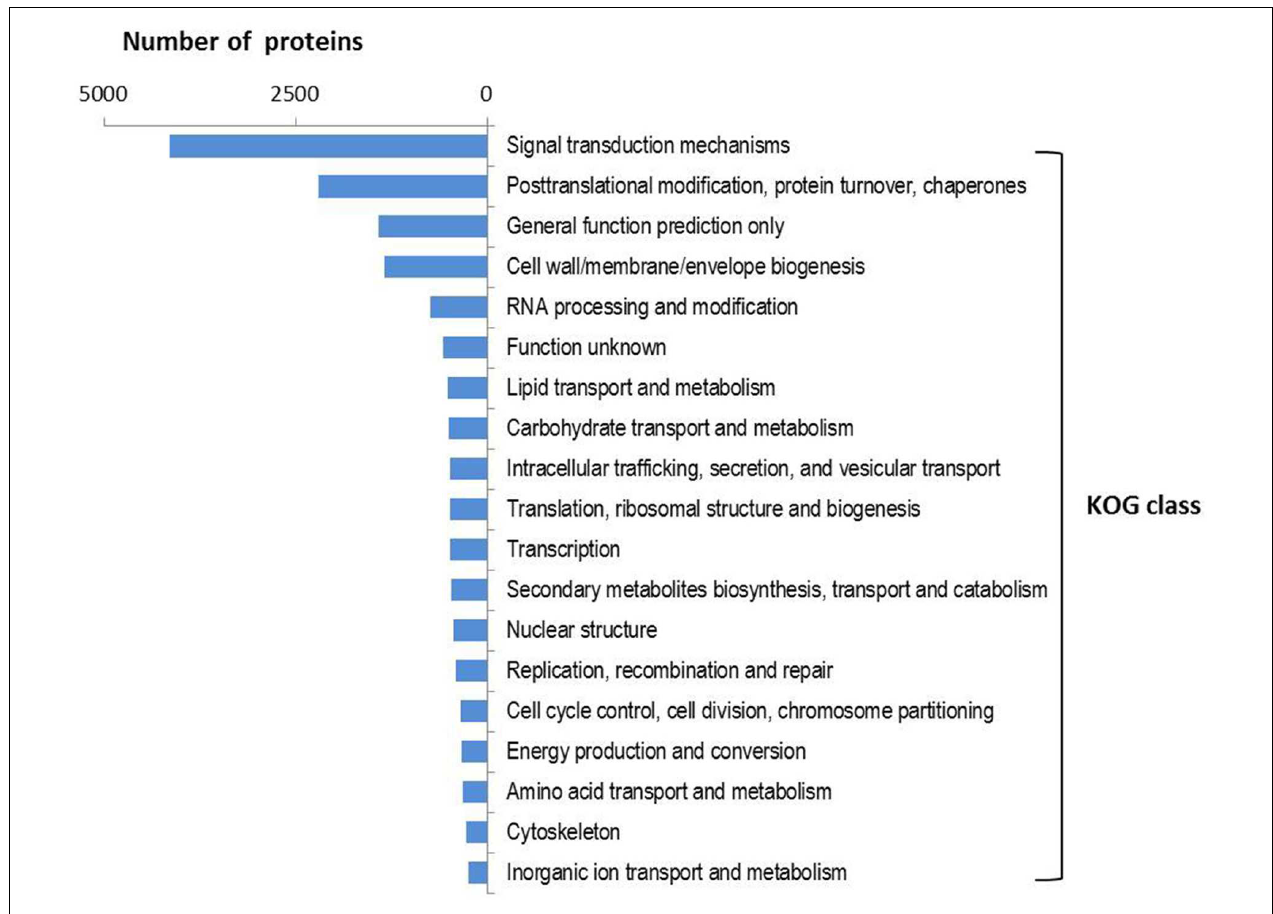
FIGURE 2 | KOG function class distribution in the predicted proteome of G . rosea. A total of 2961 KOG groups were assigned to 11505 G. rosea proteins using the webMGA tool with an e -value cut-off of 1E − 5 . The distribution of 25 KOG function classes to which these KOG groups belong is summarized as the